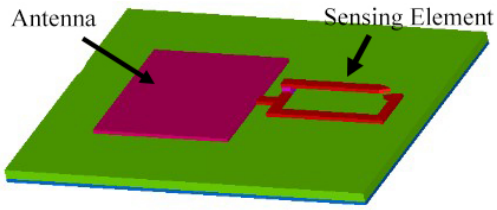
Figure 6. A chip-less RFID-based wireless strain sensor design